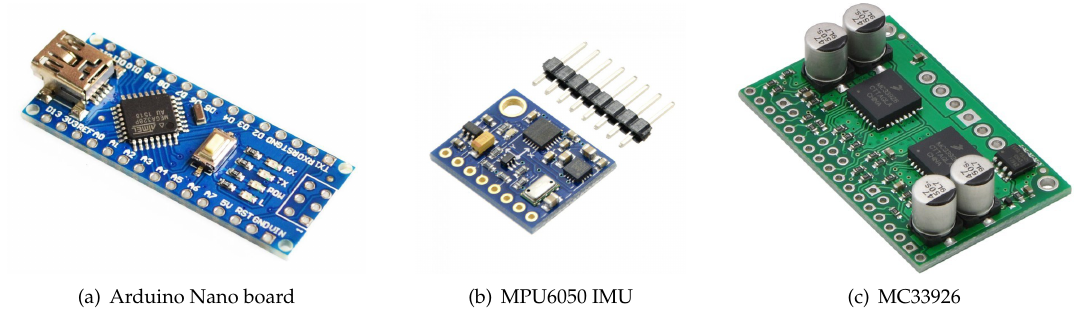
Figure 15. Physical components of the Self-Balancing